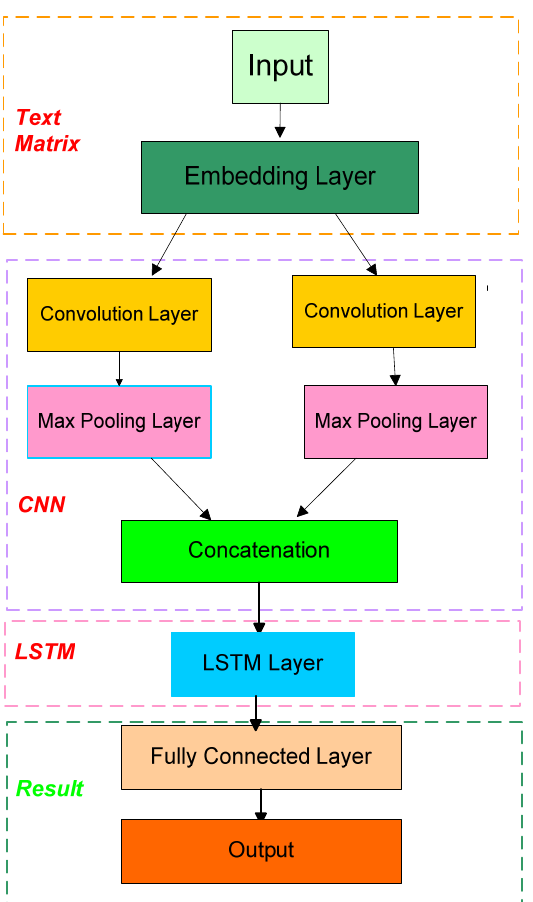
Figure 3. DRNN model’s architecture.